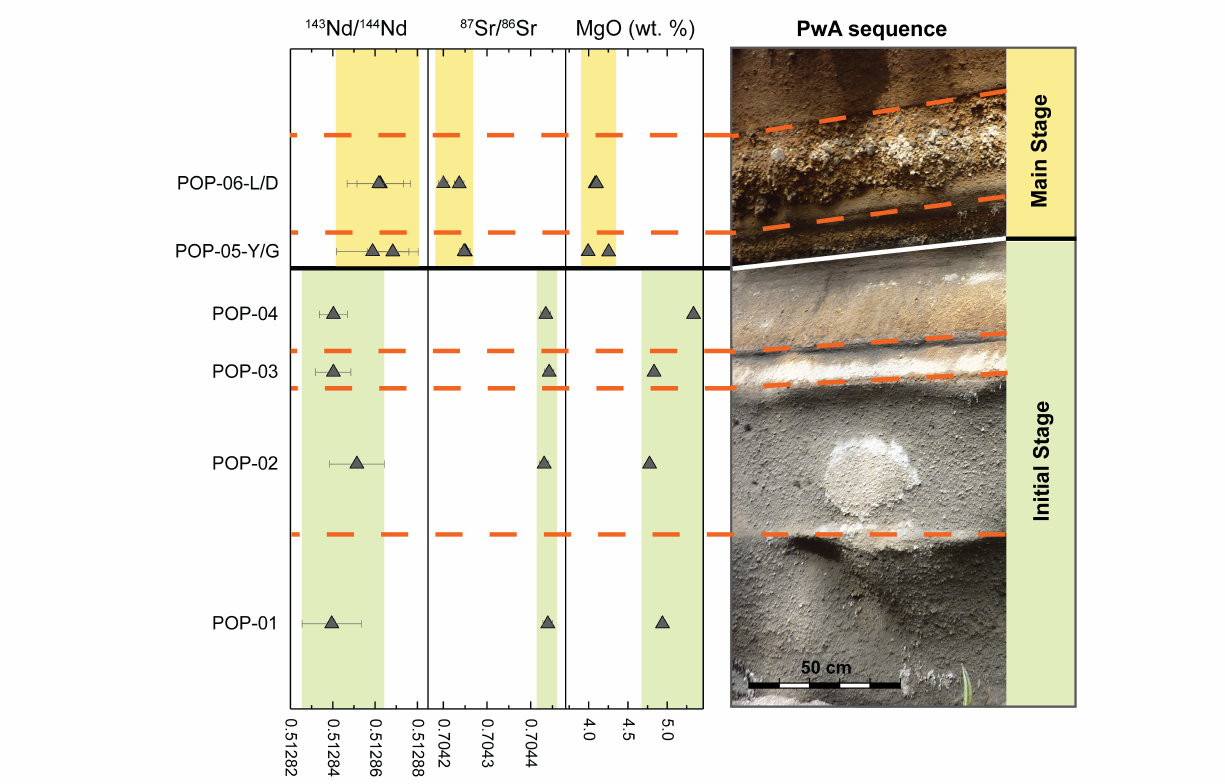
Figure 9: Chemostratigraphy of the PwA Plinian eruption 14.1 ka BP. Sr–Nd isotopic compositions and MgO show a distinct change at the transition from the initial to the main stage of the eruption. See text for further